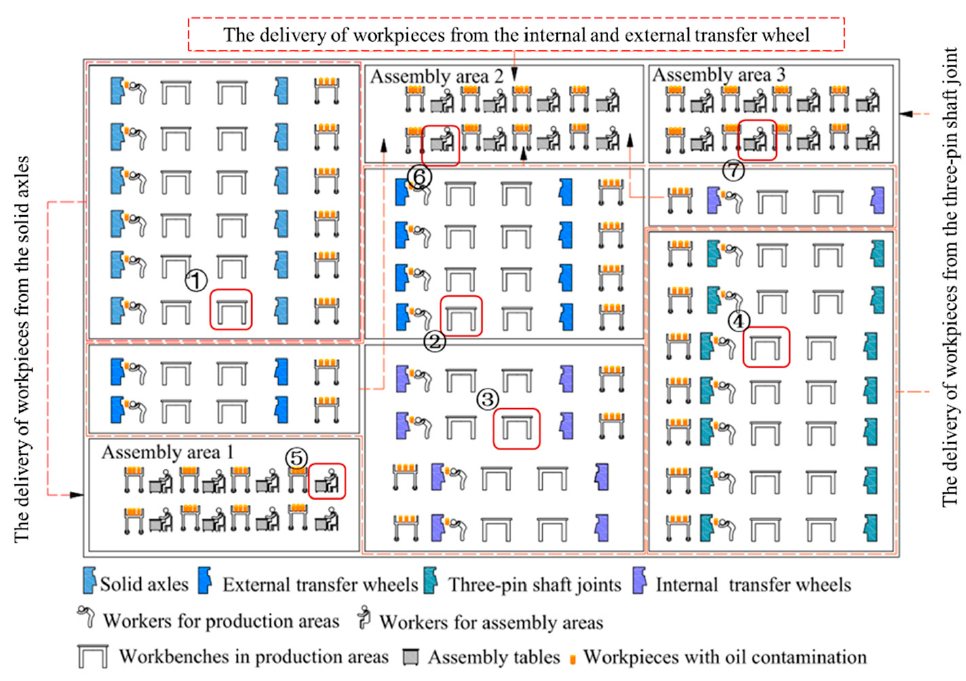
Figure 2. Internal layout of the SDS A3